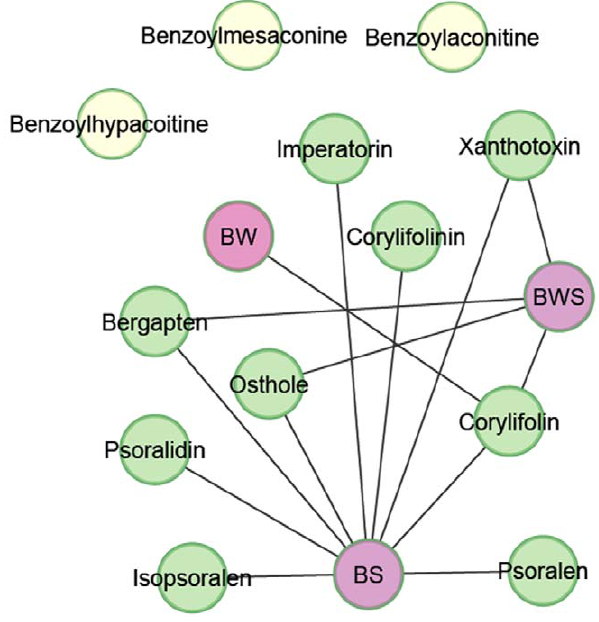
Figure 4. The drug–herb interaction network (D–H network) for BZ. BS, P. corylifolia and C. monnieri ; BW, P. corylifolia and A. carmichaelii ; BWS, P. corylifolia , C. monnieri and A. carmichaelii .